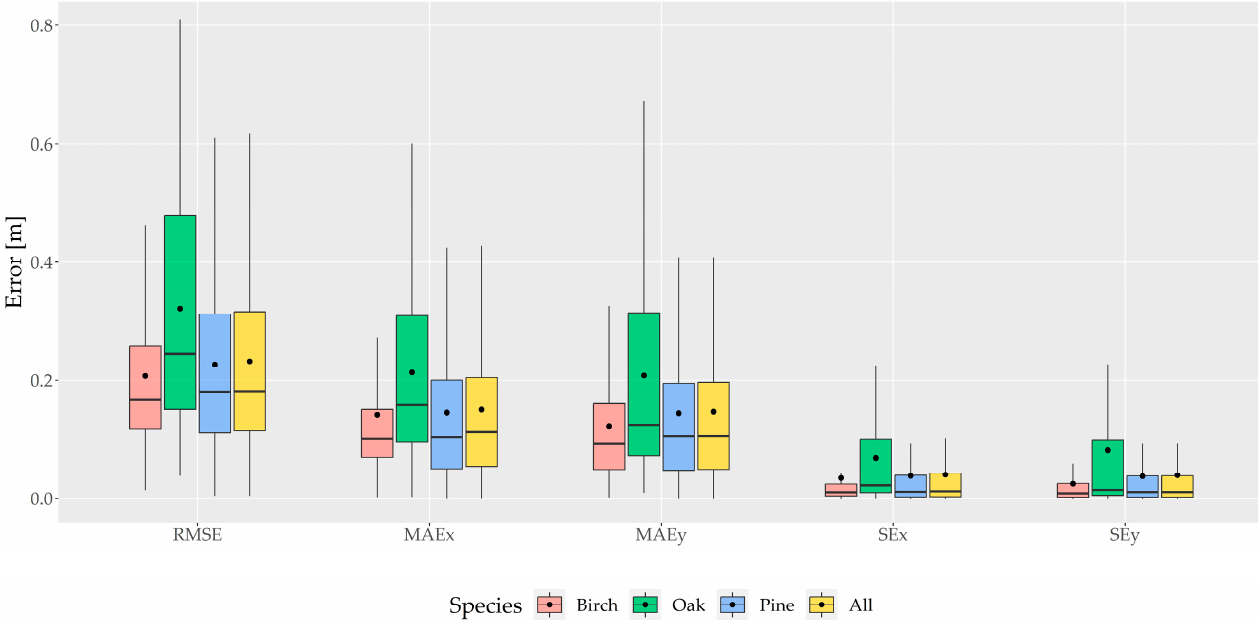
Figure 5. The boxplot represents the errors, including the type of error and main tree species. The black dot symbolizes mean value.